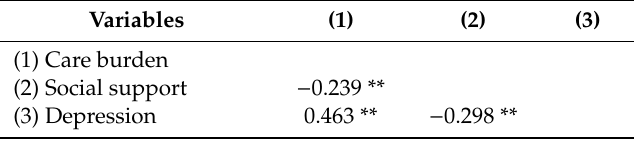
Table 3. Correlation coe ffi cients among study variables.